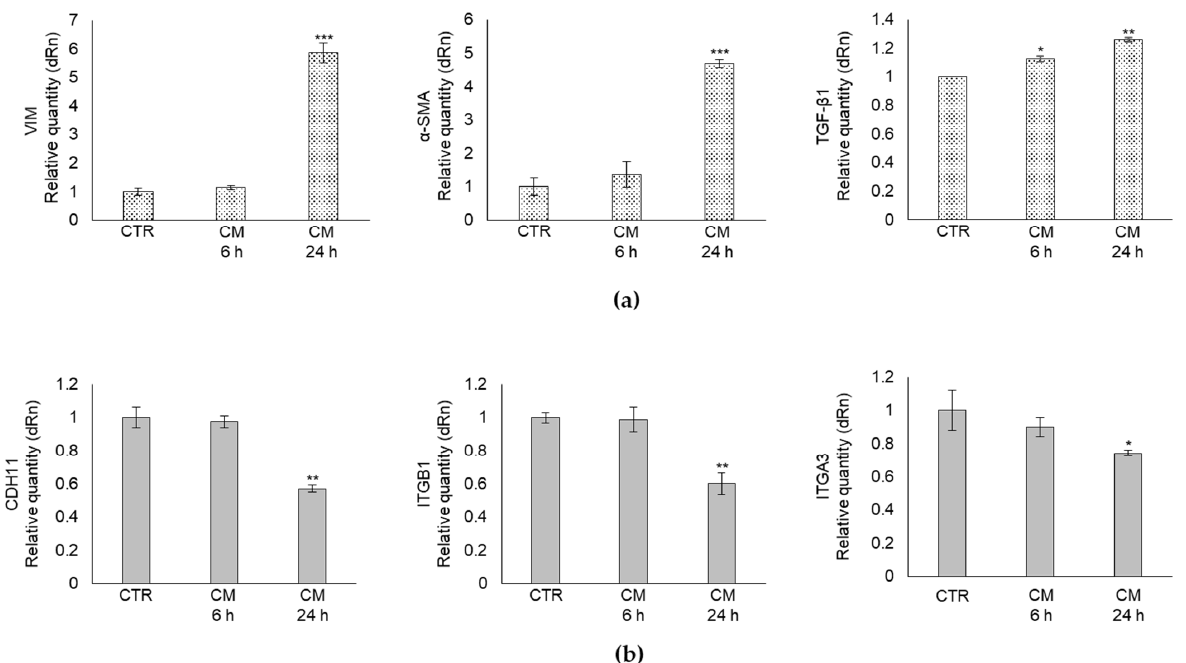
Figure 3. Effect of conditioned medium (CM) from PC3 bone metastasis-derived prostate cancer (PCa) cells on the mRNA expression of mesenchymal trans-differentiation-associated markers in human primary osteoblasts (OB). Transcript levels of ( a ) vimentin (VIM), alpha-smooth muscle actin ( α -SMA) and transforming growth factor- β 1 (TGF- β 1) mesenchymal markers or ( b ), cadherin 11 (CDH11), integrin β 1 (ITGB1) and integrin alpha 3 (ITGA3) adhesion molecules were evaluated by real-time PCR in OB exposed for 6 and 24 h to CM from PC3 cells. Control cells (CTR) are represented by OB cultured for the same period of time in their specific growth medium. Two experimental CTRs were performed for each exposure time; being both of them set at 1, each histogram reports only one CTR. The histogram indicates the mean ± SD of two different cultures, and each was tested in triplicate; * p < 0.05, ** p < 0.01, *** p < 0.001 versus CTR.